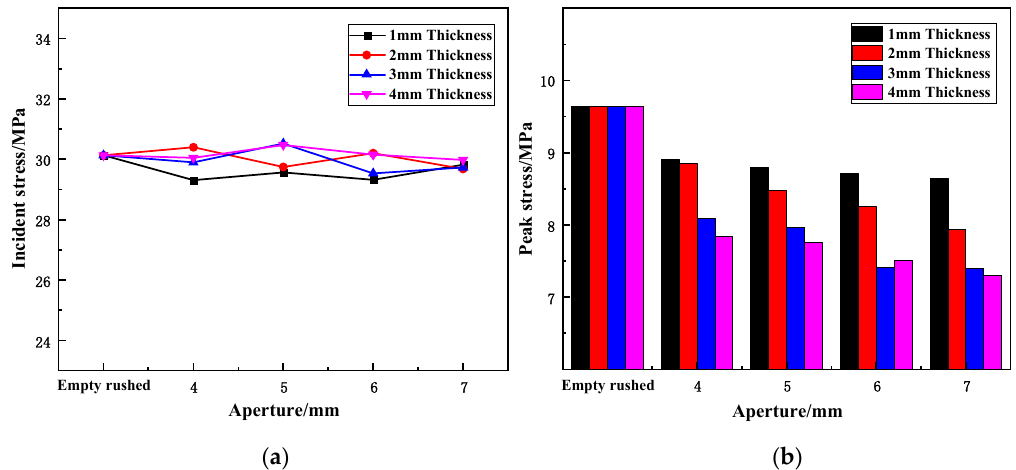
Figure 6. Variation trend of incident and reflected stress of wave-absorbing metal plate with increasing aperture size. ( a ) Variation in incident stress with aperture size. ( b ) Variation in peak stress with aperture size.